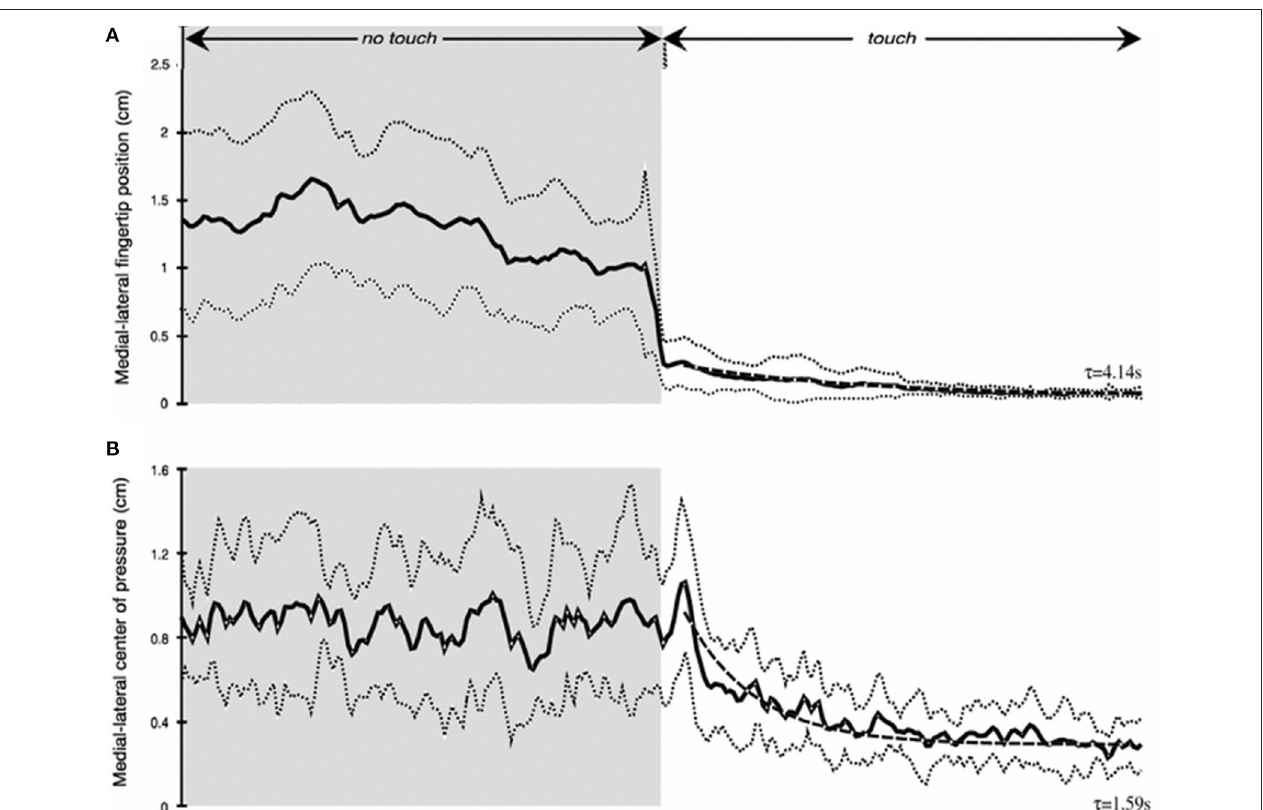
FIGURE 5 | Time course of haptic stimulation after finger contact is made ≈ 12s into 25s long trial. (A) shows medial-lateral finger position (cm) and (B) medial-lateral center of pressure (cm). Note rapid decrease in sway even prior to full finger stabilization.